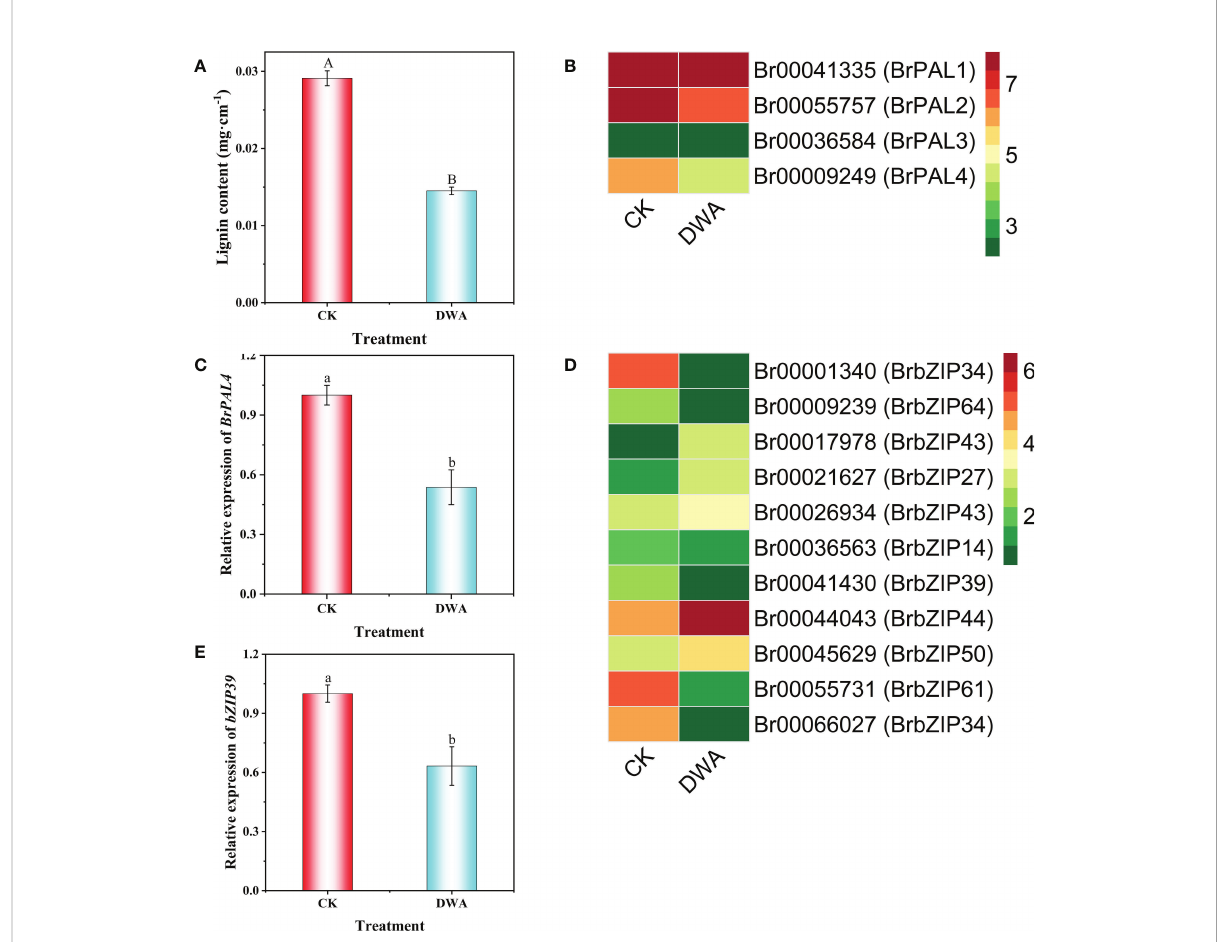
FIGURE 6 Effects of uniconazole on lignin content, BrPALs and BrbZIPs expression of hypocotyls in fl owering Chinese cabbage. Lignin content (A) , fragments per kilobase of transcript per million fragments mapped (FPKM) of BrPALs in DEGs (B) , relative expression of BrPAL4 (C) , FPKM of BrbZIPs in DEGs (D) , and relative expression of BrbZIP39 (E) in hypocotyl of fl owering Chinese cabbage seedlings under CK and DWA. The vertical bars show the standard error of the mean ( n = 3). CK, 0 mg·L -1 uniconazole (pure water); DWA, 100 mg·L -1 uniconazole. Letters above columns mean signi fi cant difference at P <